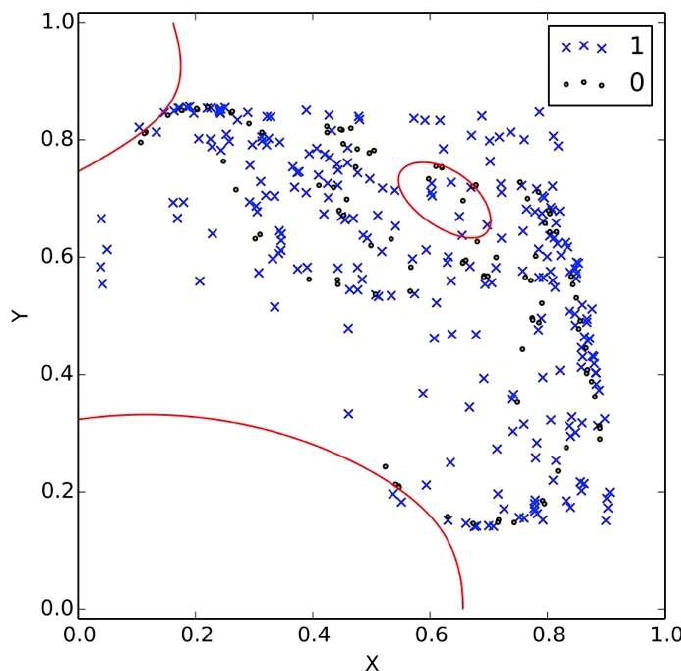
Figure 8. The decision surface (solid line) obtained from the attack when the attractor of Figure 1 has a low number of observations.